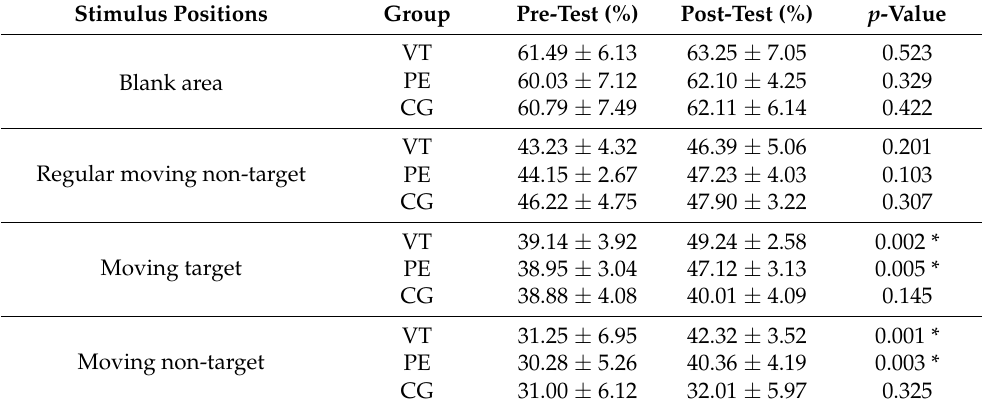
Table 3. Detection rate of probe stimulus appearing in different positions pre-test and post-test.